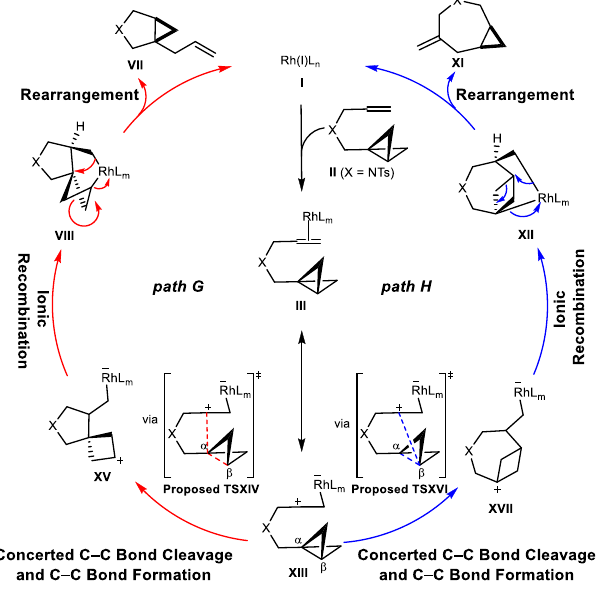
Fig. 3 | Ionic mechanisms for Rh(I)/PPh 3 -catalyzed cycloisomerization of bicyclo[1.1.0]butane. Starting from the active catalyst I , two different catalytic cycles (path G and path H) were proposed to form fi ve- ( VII ) or seven-membered ( XI ) product. Path G leads to the formation of VII , and path H gives rise to the generation of XI . Path G, solid red curve; Path H: solid blue